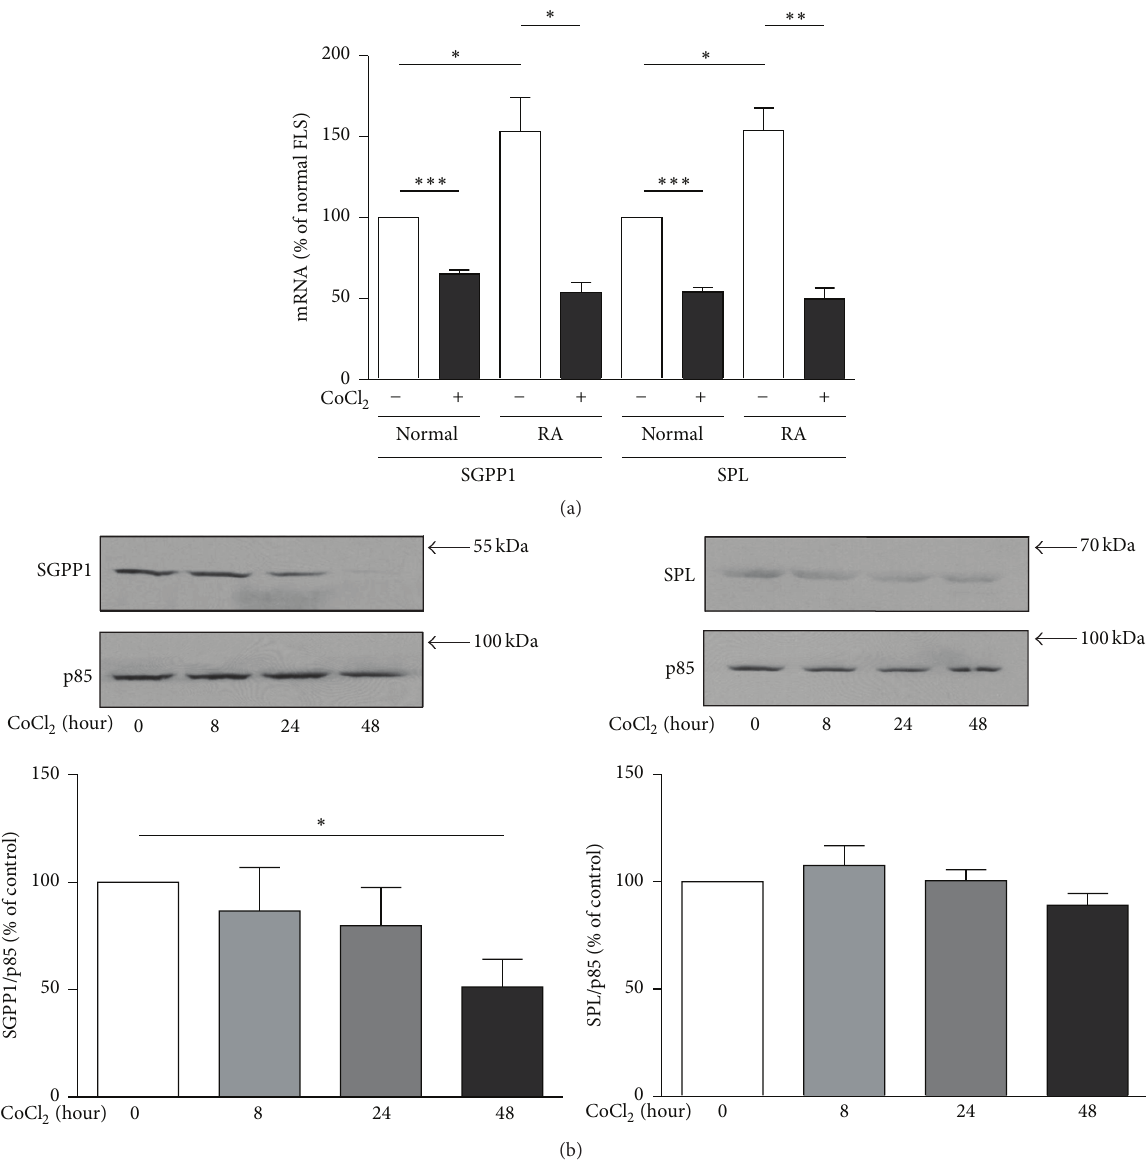
Figure 4: Differential expression of SGPP1 and SPL in normal FLS and RAFLS. Human primary FLS from normal ( 𝑛 = 4 ) and RA ( 𝑛 = 4 ) donors were incubated with or without 200 𝜇 M CoCl 2 for 24 h. Total RNA was extracted for quantitative PCR analyses and RPLP0 was used as an internal control and data normalized to that of normal FLS (a). The data are the means ± SE from four experiments (4 different donors) performed in triplicate (3 independent experiments). For statistical analyses, we compared the cells stimulated with CoCl 2 to those without CoCl 2 , or normal FLS to RAFLS. ∗ 𝑝 < 0.05 ; ∗∗ 𝑝 < 0.01 ; ∗∗∗ 𝑝 < 0.001 . Human primary FLS from RA patients ( 𝑛 = 3 ) were incubated with 200 𝜇 M CoCl 2 for up to 48h (b). Proteins from whole cell lysates were prepared for Western blot. Total PI3-kinase p85 subunit was used as a control for protein loading. Data presented are from a representative blot (upper panel) or the means ± SE from three experiments (lower panel). For statistical comparative analyses, the samples stimulated with CoCl 2 at 0 h were compared to those treated for indicated times. ∗ 𝑝 < 0.05